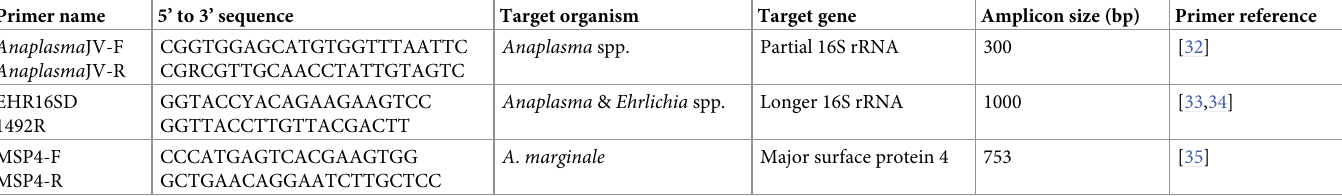
Table 1. Primers for PCR